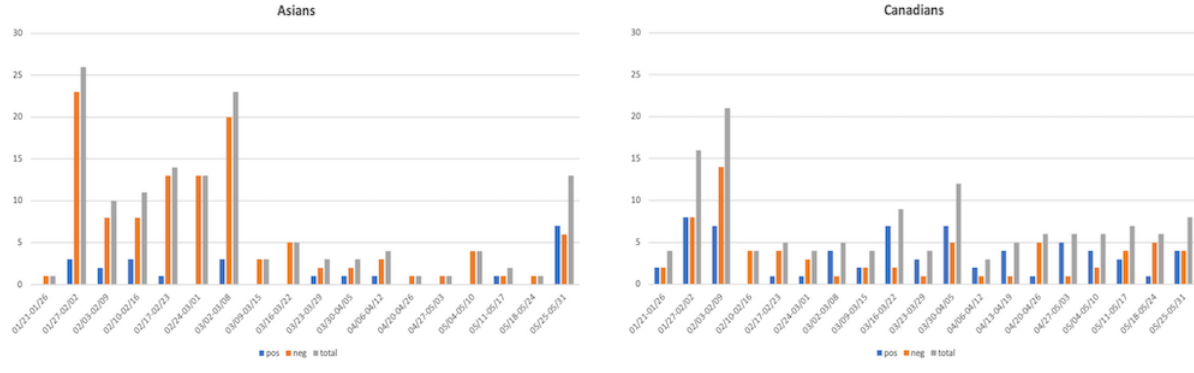
Figure 6. Sentiment changes over time for Asians and Canadians. Y-axis shows the number of positive occurrences, number of negative occurrences, and number of total occurrences. neg: negative; pos: